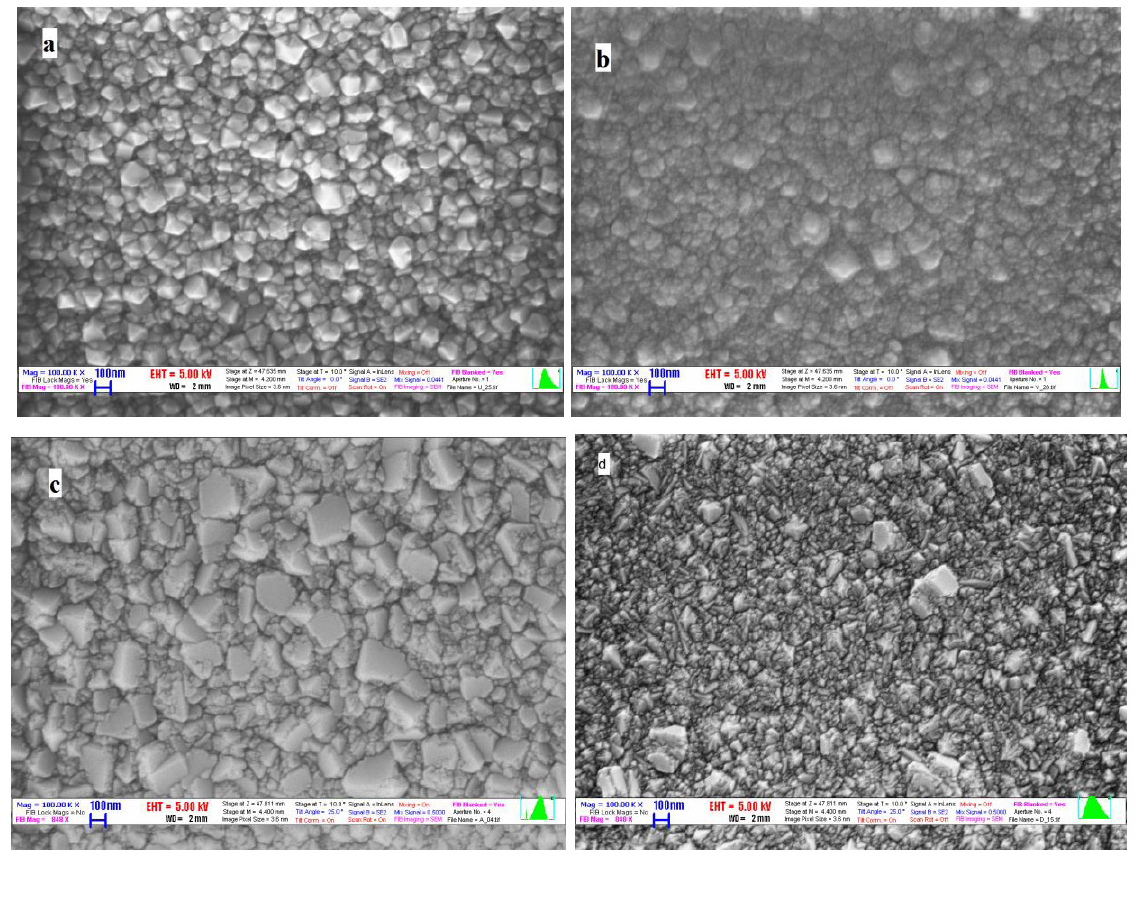
; (b) T=700°C and 2.0% CH 4